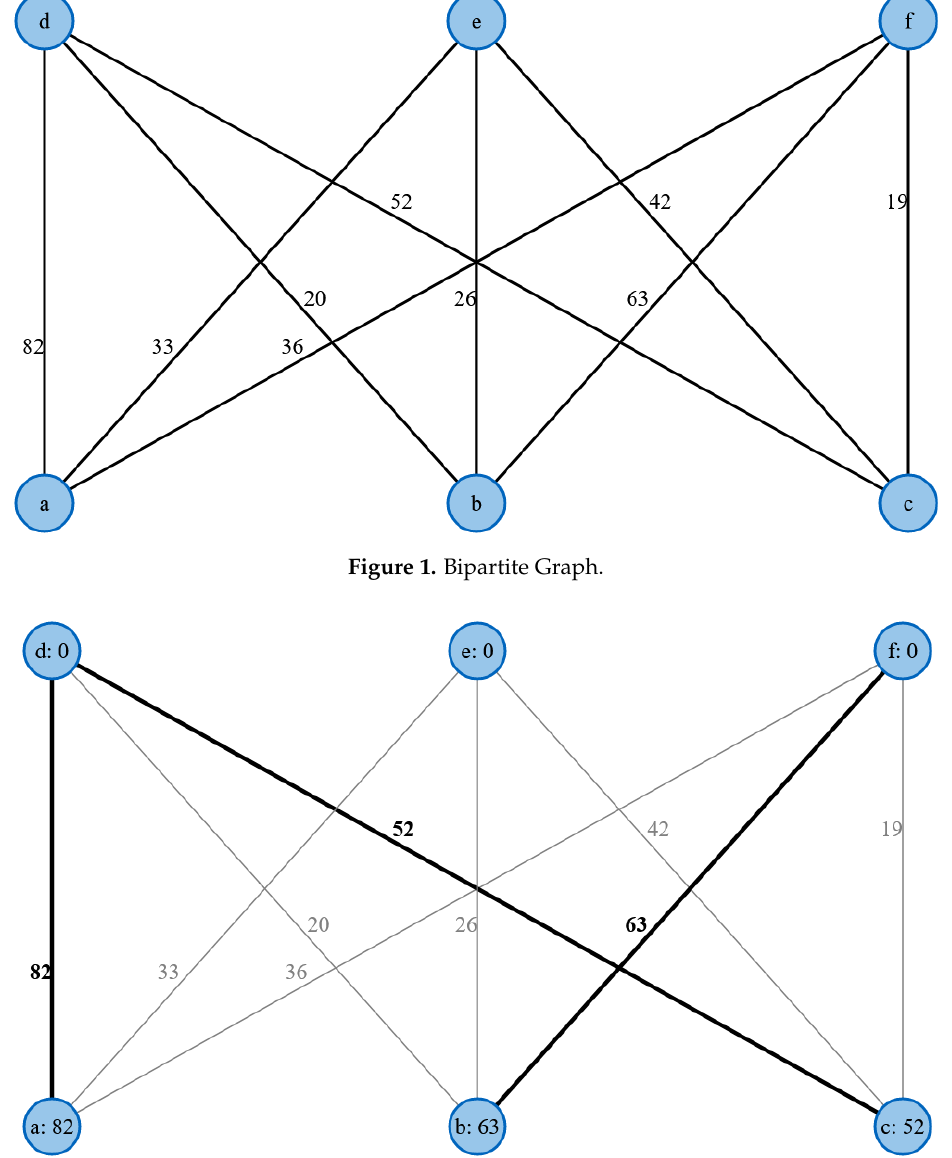
Figure 2. Determine the augmentation